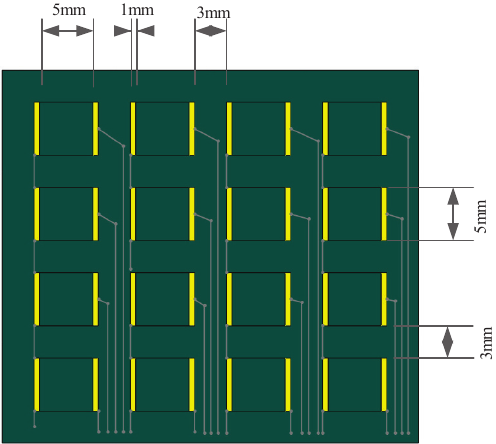
Figure 3. Design of the electronic